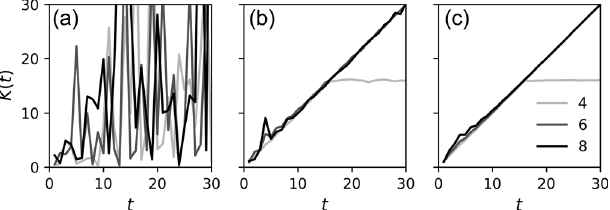
FIG. 3. SFF of the Haar-RFC with different degrees of averaging. All data are for periodic boundary conditions, with the number of sites L shown on the legend. (a) No averaging: For each L , this is the SFF for an individual realization of the